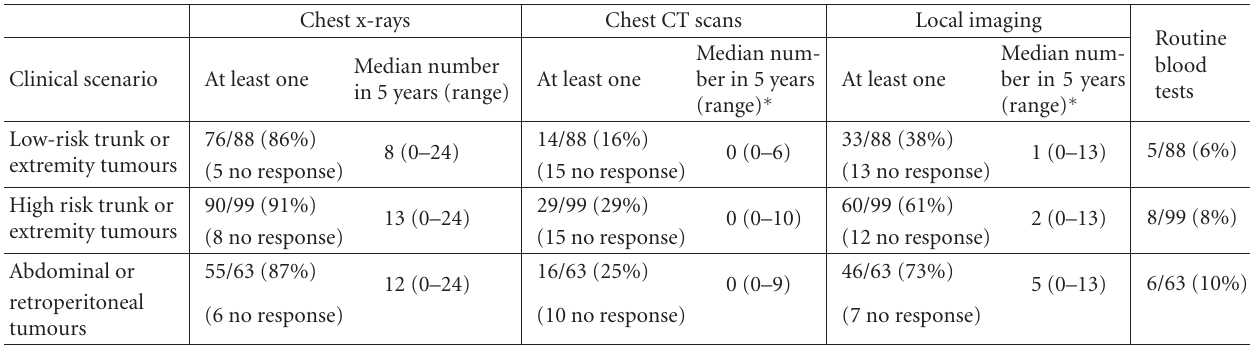
Table 3: The use of radiological investigations or blood tests for follow